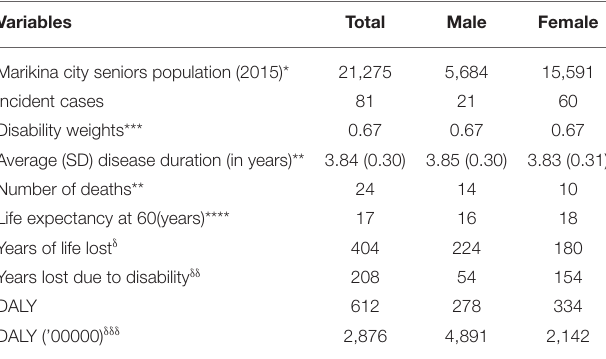
TABLE 4 | Data for the computation of disability-adjusted life